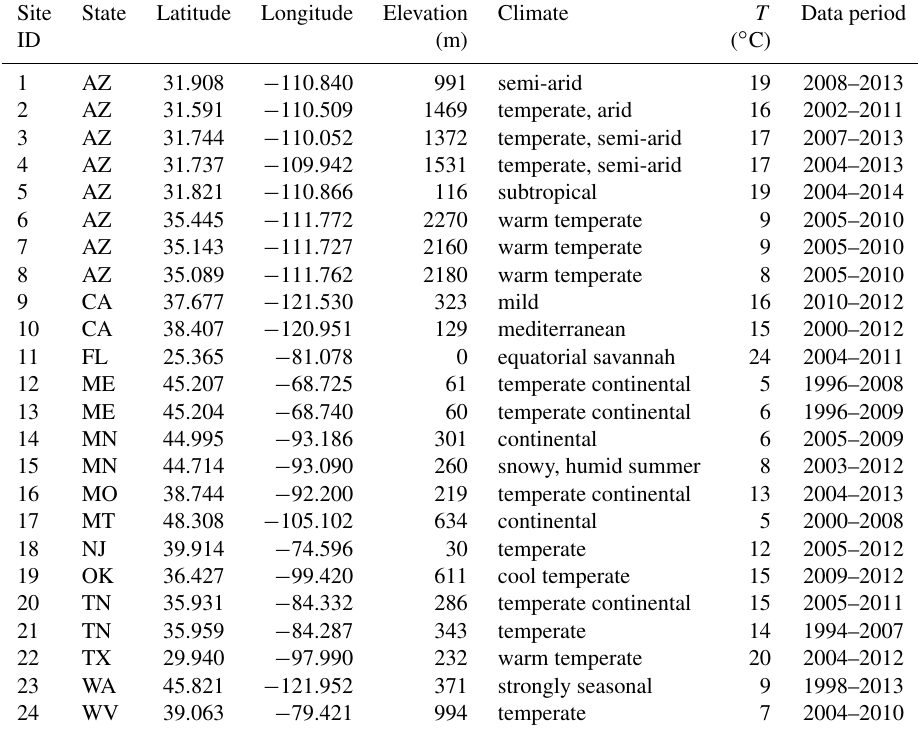
Table 4. Some general and climatic characteristics of the sites used for calibration: elevation is the site elevation above sea level, T is the annual average temperature, and data period refers to the period of available measurements.